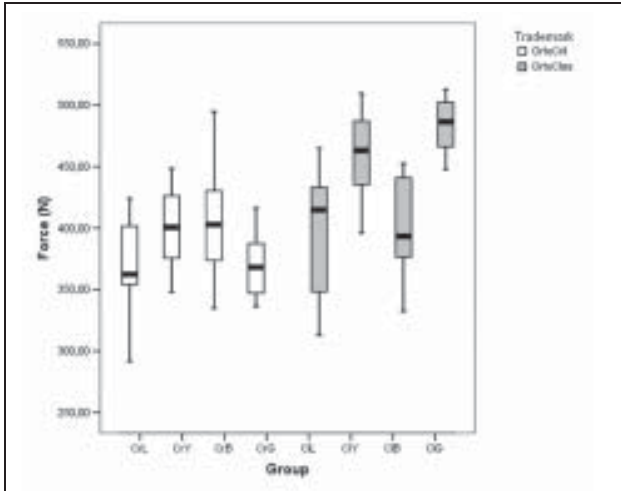
Figure 3 – Box Plot comparing trademarks and colours of acrylic resins. Mean, SD, max,